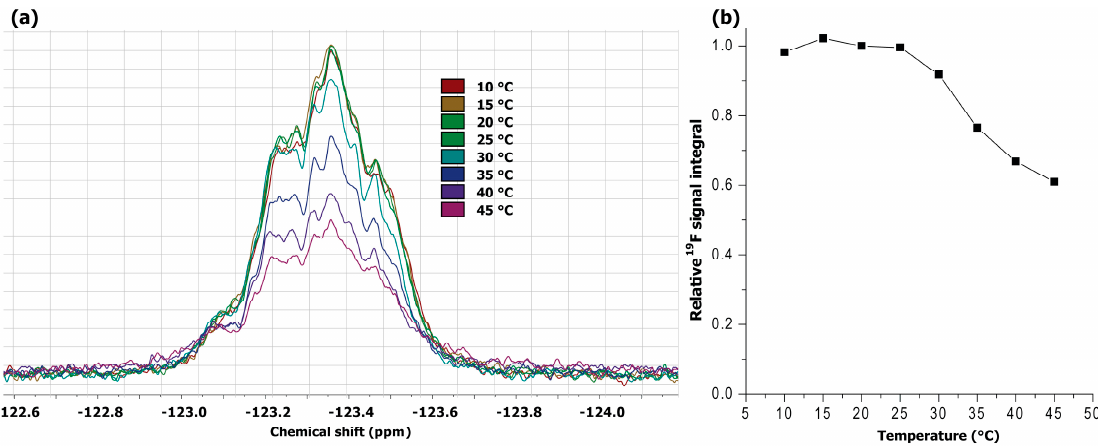
Figure 8. ( a ): Stacked 19 F NMR spectra of HF polymer at different temperatures; ( b ) the relative integral of the detected 19 F signal as a variance of temperature.